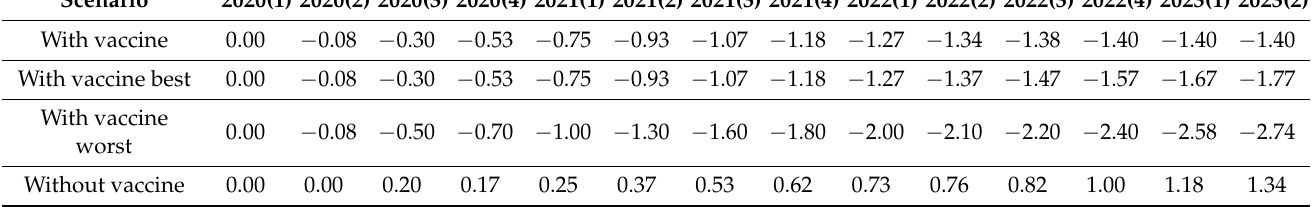
Table A5. Percentage (%) points reduction in population growth with and without vaccine vs. no COVID